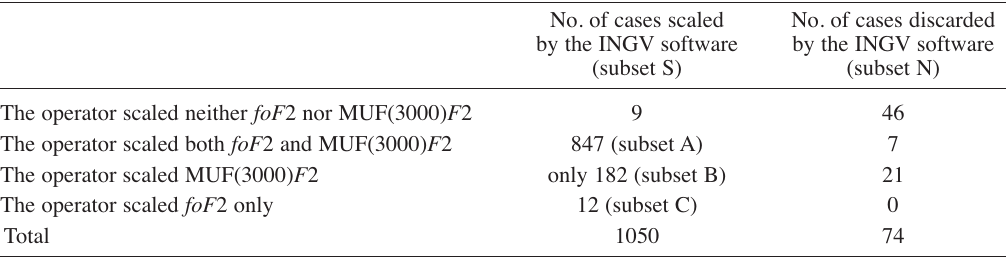
Table III. Test results of the software capability in identifying ionograms with sufficient